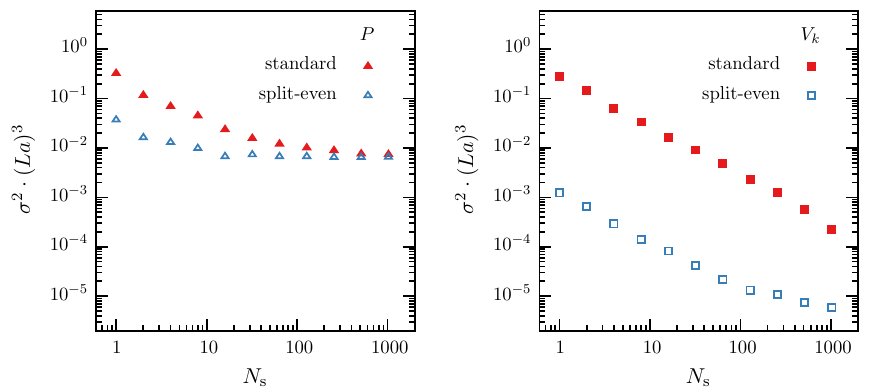
Fig. 4 Variances of the standard θ (cid:6), (filled red symbols) and the split- ensemble F7 and for the bare quark masses am q , r = 0 . 00207 and rs am q , s = 0 . 0189correspondingtotheseaandapproximatelythestrange even τ (cid:6), (open blue symbols) estimators for differences of single- rs propagator traces for the pseudoscalar density (left) and the vector cur- quark rent (right) as a function of the number of random sources N s for the